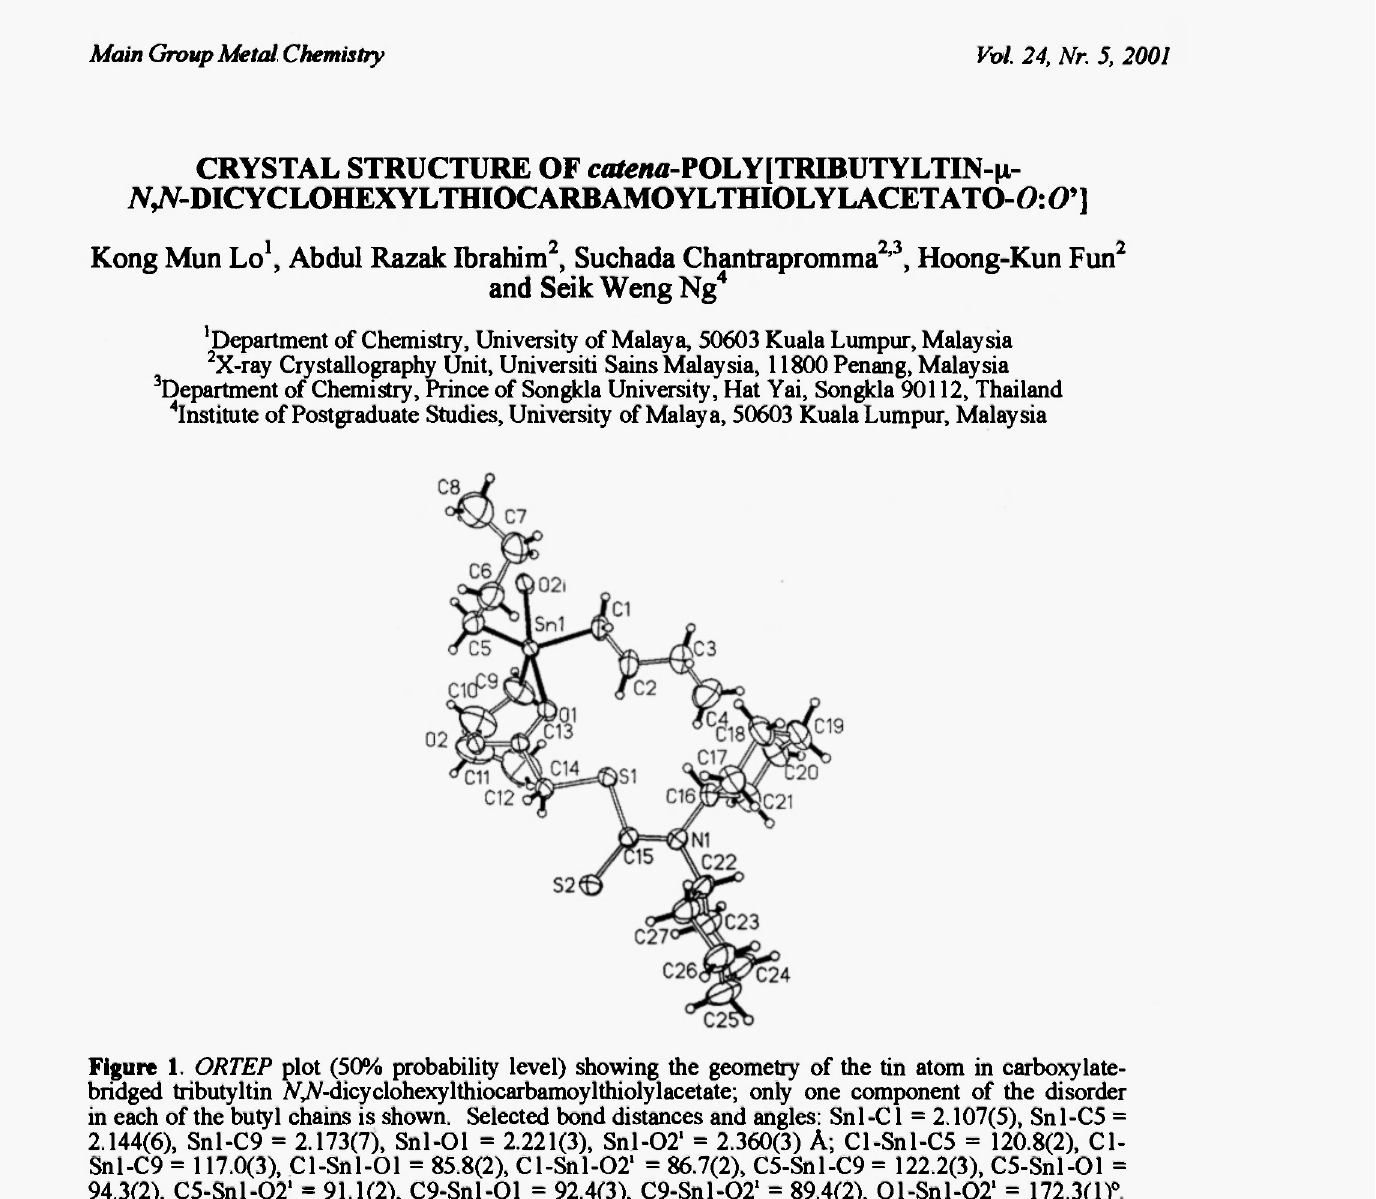
Figure 1. ORTEP plot (50% probability level) showing the geometry of the tin atom in carboxylate- bridged tributyltin A^V-dicyclohexylthiocarbamoylthiolylacetate; only one component of the disorder in each of the butyl chains is shown. Selected bond distances and angles: Snl-Cl = 2.107(5), Snl-C5 = 2.144(6), Snl-C9 = 2.173(7), Snl-Ol = 2.221(3), Snl-02 1 = 2.360(3) A; Cl-Snl-C5 = 120.8(2), Cl- Snl-C9 = 117.0(3), Cl-Snl-Ol = 85.8(2), Cl-Snl-02' = 86.7(2), C5-Snl-C9 = 122.2(3), C5-Snl-01 = 94.3(2), C5-Snl-02' = 91.1(2), C9-Snl-01 = 92.4(3), C9-Snl-02' = 89.4(2), Ol-Snl-02 1 = 172.3(1)° Symmetry transformation: i= x- 1/2, 1/2